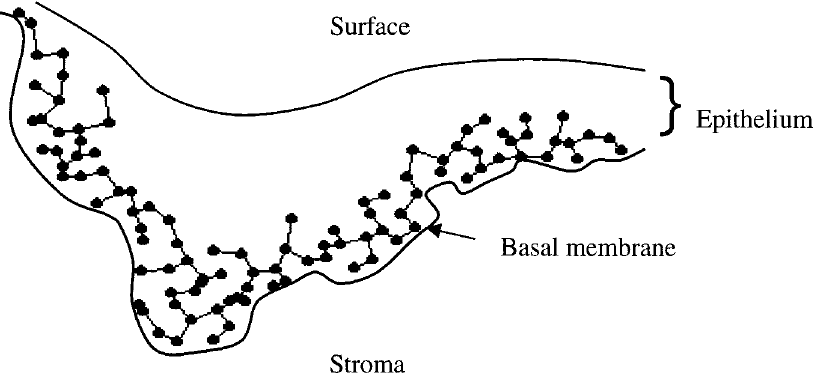
Fig. 5. The minimum spanning tree (MST) schematically drawn for the basal cell layers in normal oral mucosa. The MST represents the length of the shortest paths (or tours) through each point exactly once